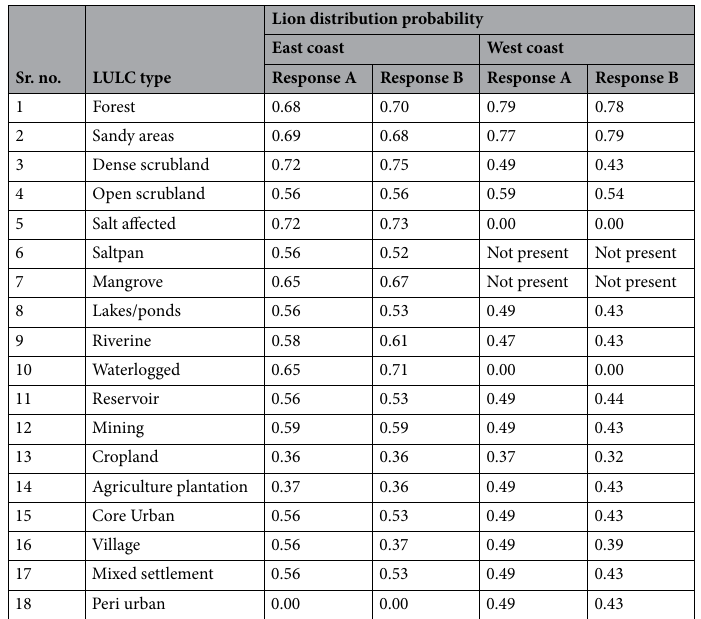
Table 2. Lion distribution probability (logical output of MaxEnt model) for each Land Use Land Class (LULC) type for the eastern and western coast. Response A is the lion distribution probability for the LULC variable while keeping other variables at average value, while Response B is the distribution probability considering only the LULC